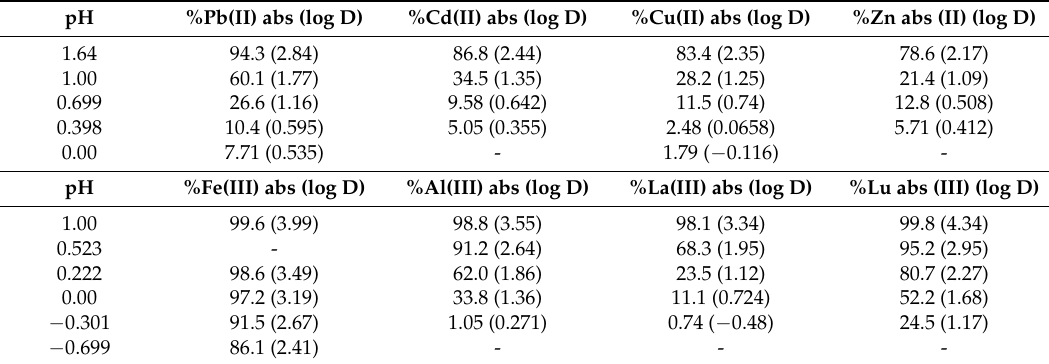
Table 3. Metal ion affinities of the diprotic phosphonic acid (DPA).